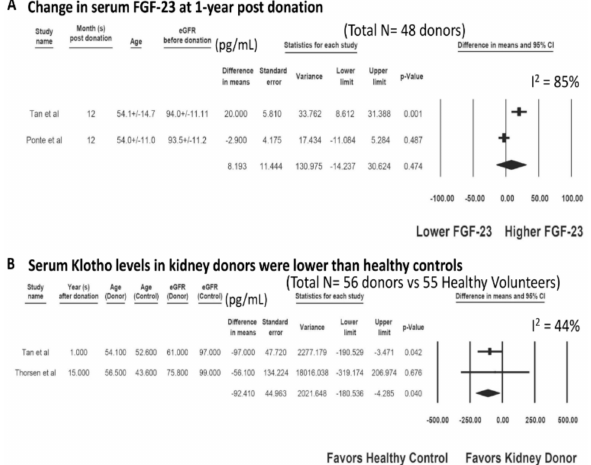
Figure 4. ( A ) Changes in Serum FGF-23 at one year post-donation and ( B ) Serum klotho levels in kidney donors compared to unmatched healthy